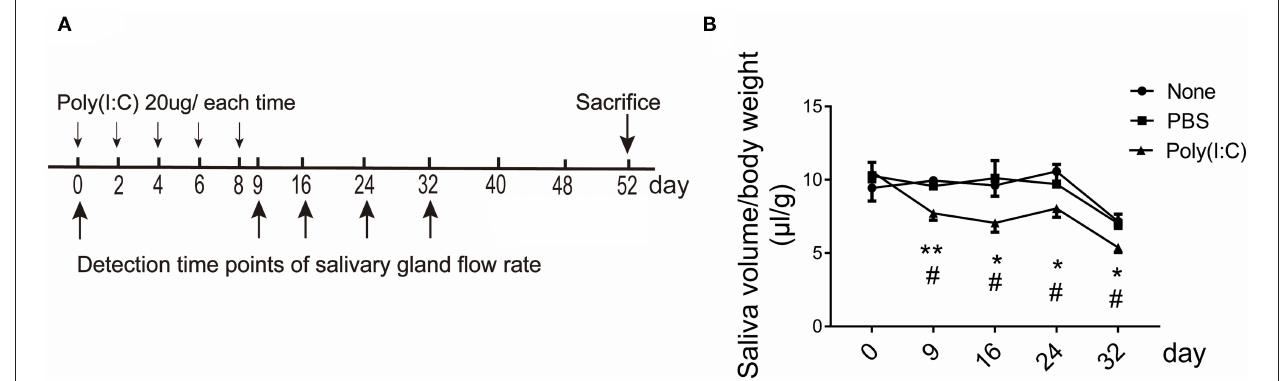
FIGURE 1 | The saliva flow rate in NOD mice intratracheally treated with poly(I:C). (A) Administration regimen for the induction of poly(I:C)-treated mice. (B) Pilocarpine-induced saliva volume was determined every 8 days. The number of the three groups were 6, 6, and 8, respectively. Data were presented as mean ± SEM, *poly(I:C) vs. none, * p < 0.05, ** p < 0.01; # poly(I:C) vs. PBS, # p <